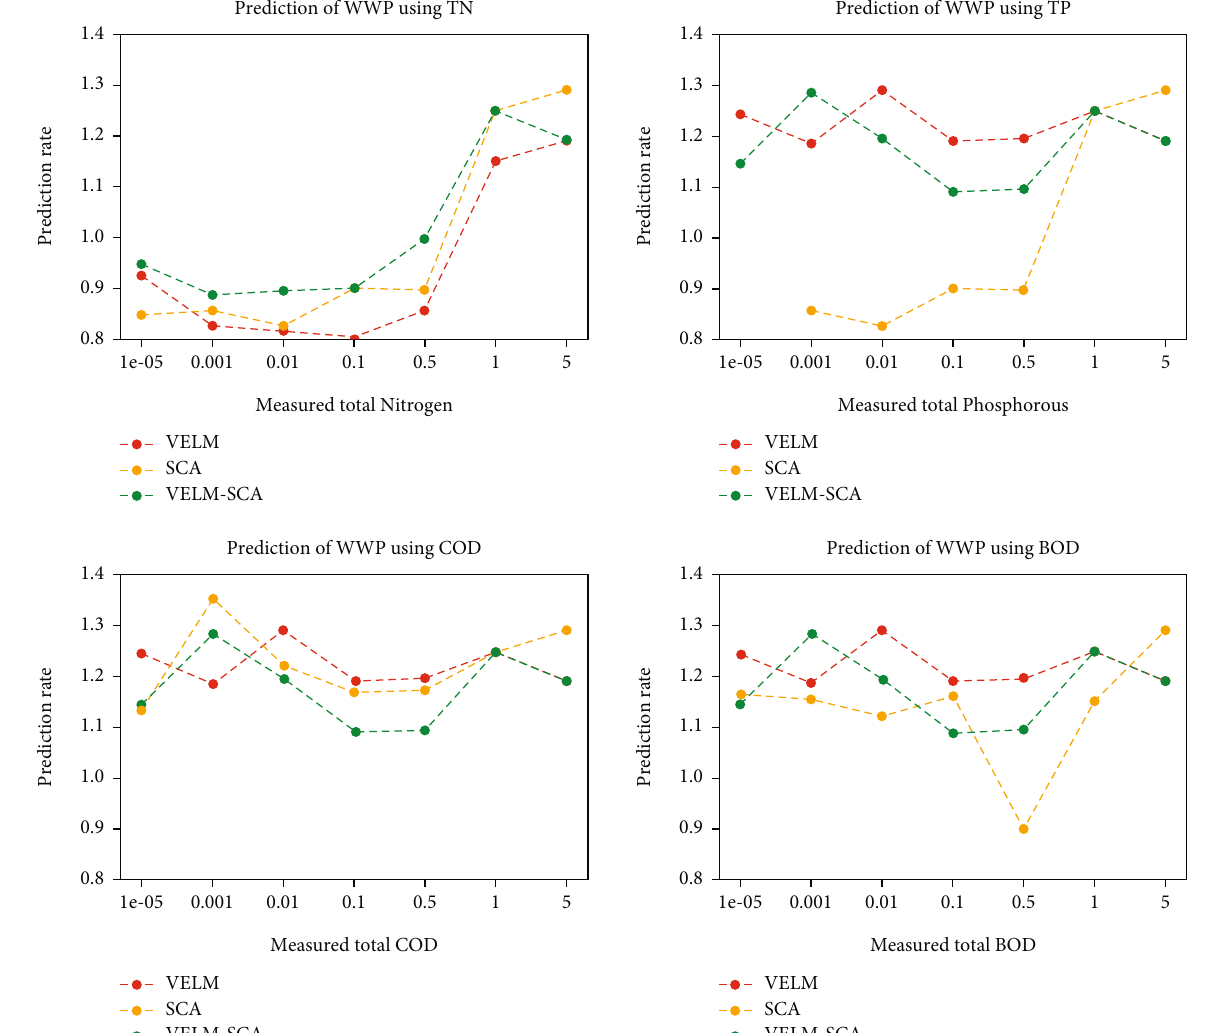
Figure 4: Statistical analysis of prediction of various